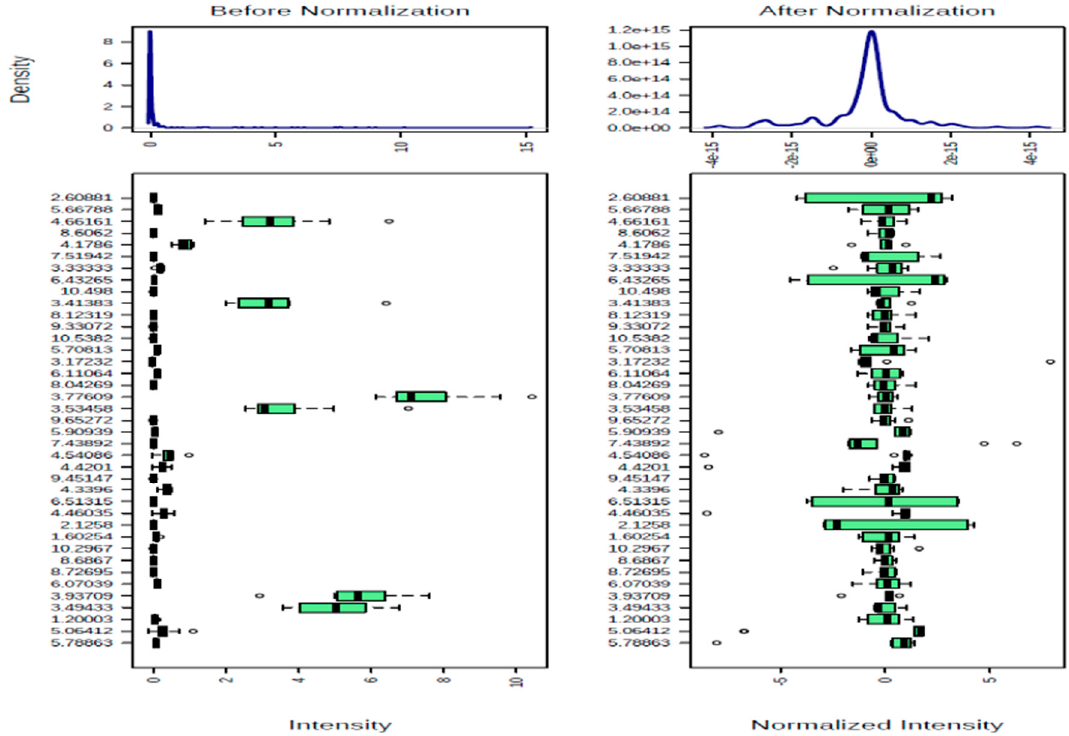
Figure 8. Log 2 transformed normalisation of HA-HJ using Pareto scaling for MetaboloAnalyst 3.0 software.